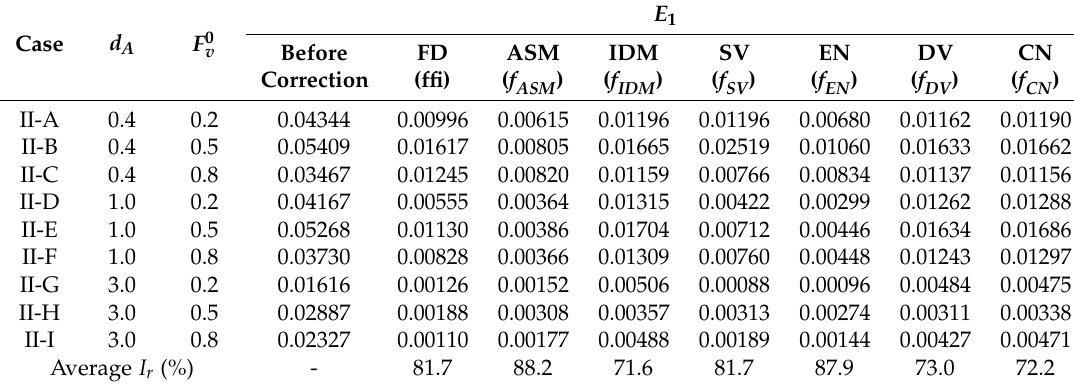
Table 3. Error index ( E 1 ) before and after correction using seven types of texture analysis indices (FD, ASM, IDM, SV, EN, DV, and CN), for Case II (irregularly-shaped particles with Boolean internal structure), along with the corresponding average improvement rate ( I r